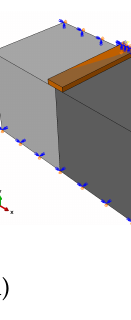
Figure 19. ( a ) Model of splitting test. ( b ) Mesh adopted in the analysis—element size in the vicinity of the interface—5 mm.